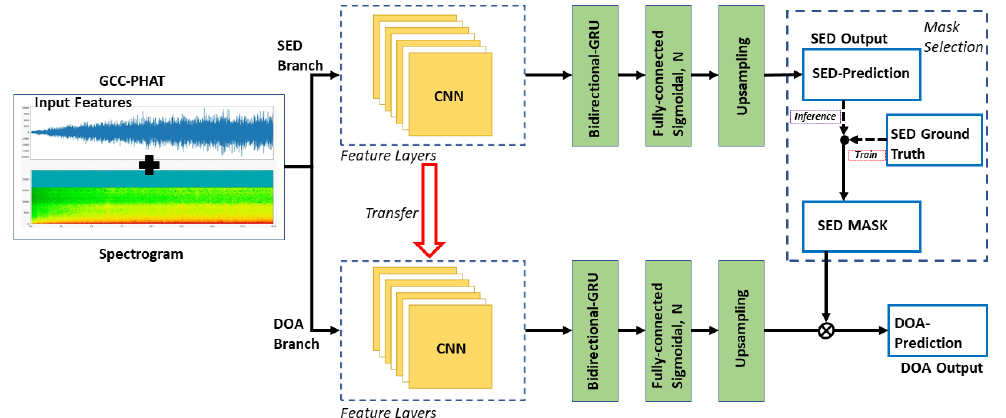
Figure 6. The developed neural network with two branches wherein the SED branch is used to detect the sound event class, which is used to mask to infer the DOA branch that detects the sound event directional coordinates.